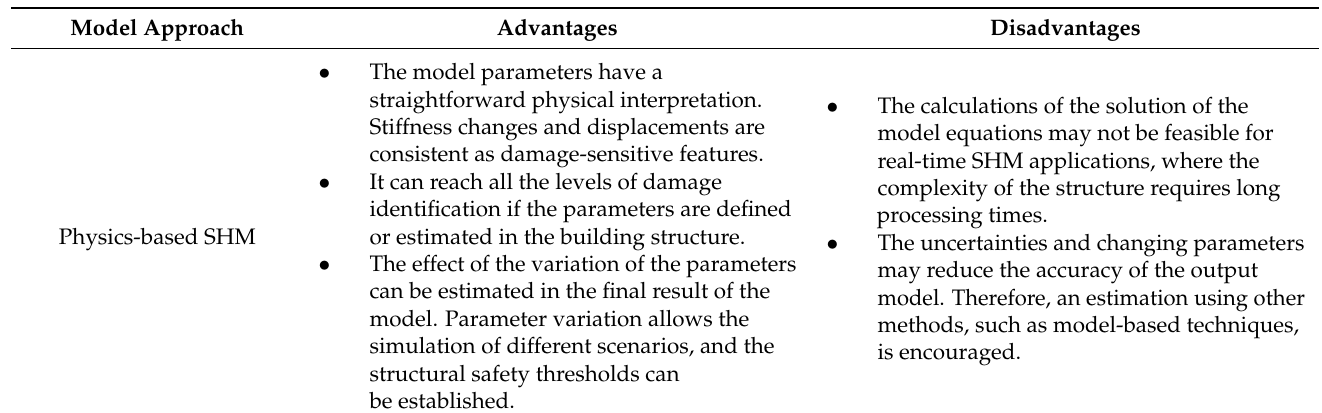
Table 11. Advantages and disadvantages of a physics-based model and data-based models in SHM building